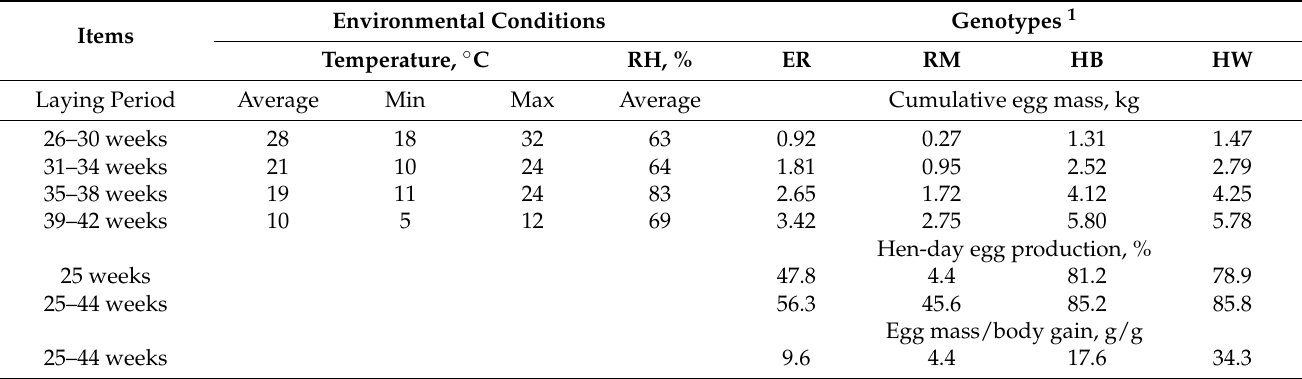
Table 1. Environmental temperature and relative humidity, and productive performance of purebred and hybrid genotypes throughout the laying